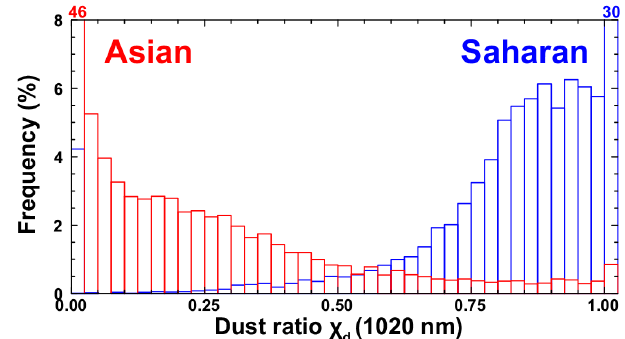
Figure 4. Histograms of χ d for the considered AERONET stations affected by Saharan (blue) and Asian dust (red). The coloured num- bers provide the values for bars that exceed the